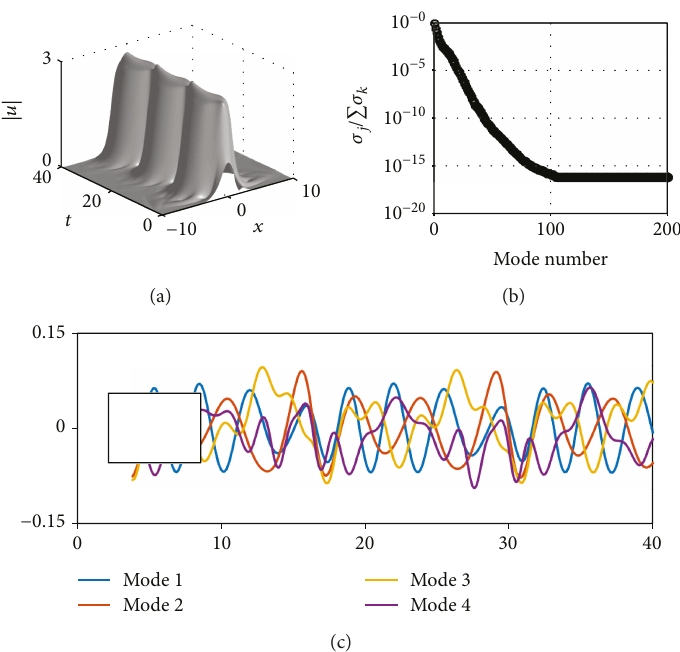
Figure 6: Spatio-temporal breather solution of the CQGLE equation for the parameter regime τ = 0 08 , κ = 0 , β = 0 66 , ν = − 0 1 , σ = − 0 1 , and γ = − 0 1 . Although the dynamics illustrated (a) look relatively simple, the singular value decay (b) shows that a large number of modes are required to reconstruct the fi ne spatio-temporal features of the nonlinear evolution. Moreover, the temporal dynamics of the fi rst four POD modes, which are extracted from the columns of the V matrix of the SVD (c), characterize a complicated temporal behavior for the individual modes. Unlike the NLS example, a low-rank approximation does not work well for reconstructing the dynamics. The simulation was performed over t ∈ 0, 40 with 301 equally spaced snapshots taken. The domain was discretized with n = 512 points on a domain x ∈ − 10, 10 .